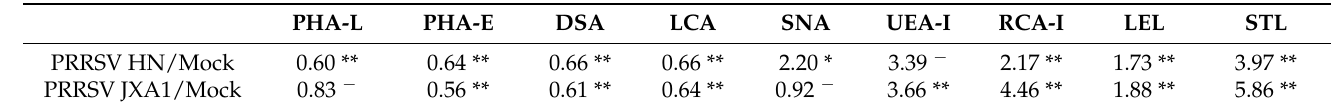
Figure 5. Fluorescence intensity analysis of the lectin microarray. ( A ) Normalized values of fluores- cence signal intensities at positive lectin sites. ( B ) Heat map and hierarchical clustering of the positive lectins in PPMVECs. Samples are listed in columns and lectins in rows. Table 1. The fluorescence intensity fold change of significantly differentially expressed lectin sites in HP-PRRSV HN and JXA1 strain-infected PPMVECs.